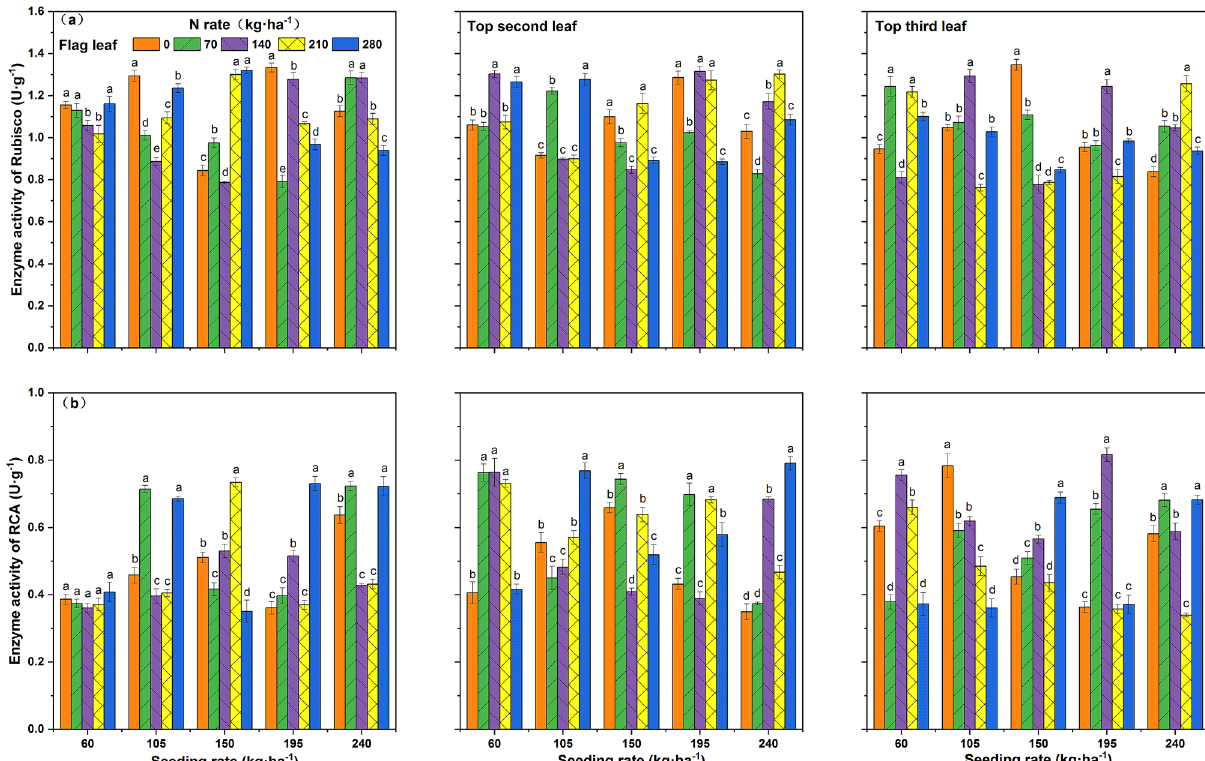
Figure 3. Effects of the interaction between seeding rate and nitrogen rate on Rubisco and RCA activities at different leaf positions of the rice population 10 days after flowering under dry cultivation. ( a ) Rubisco activity in the flag leaf, first second leaf, and first third leaf. ( b ) RCA activity of the flag leaf, first second leaf, and first third leaf. Different letters with the same sowing amount indicate a significant difference at P < 0.05. The figures were prepared and combined using Origin 2018 (www. origi nlab.